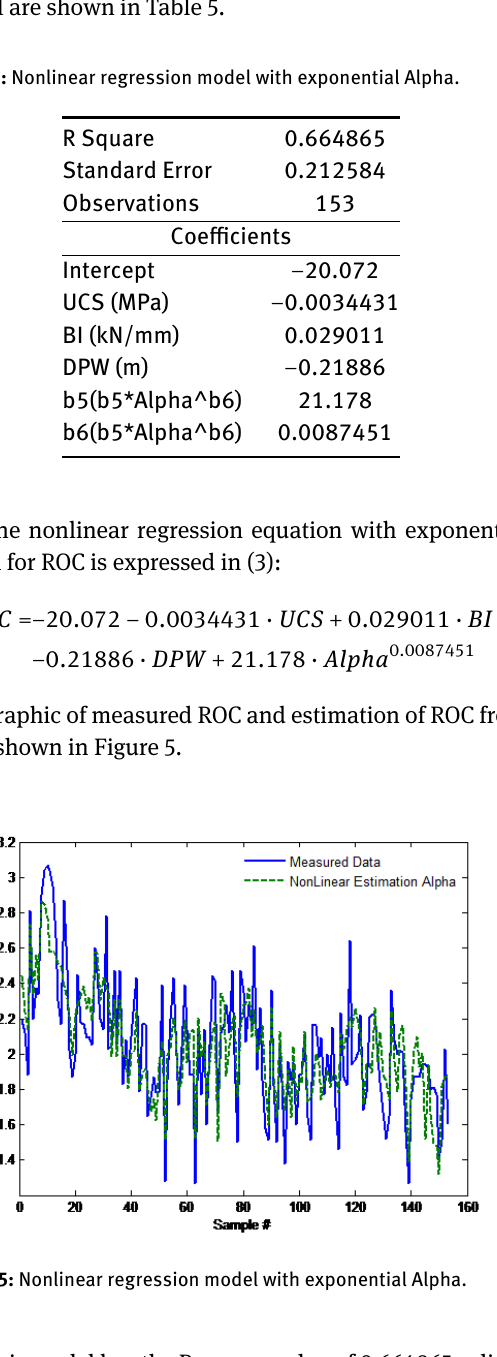
Figure 6: Nonlinear regression model with DPW &